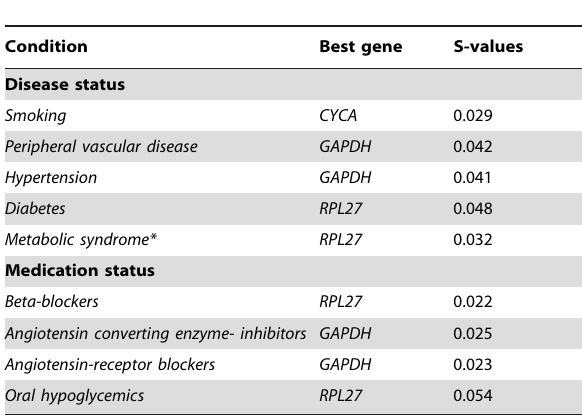
disease and medication status of the subjects using Normfinder.